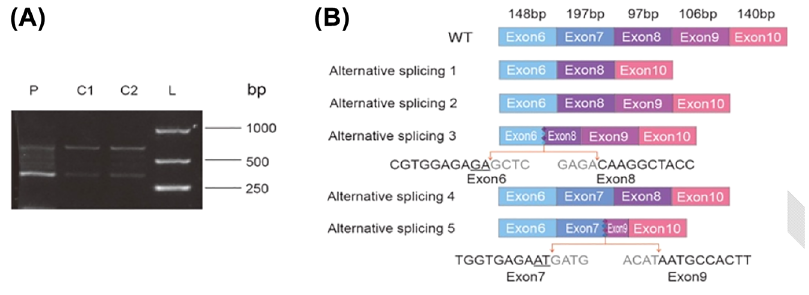
Figure3: (A)Agarose-gel (1%)electrophoresisof reversetranscription-polymerasechainreaction(RT-PCR)products.C1:normalcontrol1;C2: normal control 2; P: patient 1 ’ s father; L: DNA ladder (Takara DL 10,000 marker). (B) Sketch map of sequence details involved in aberrant